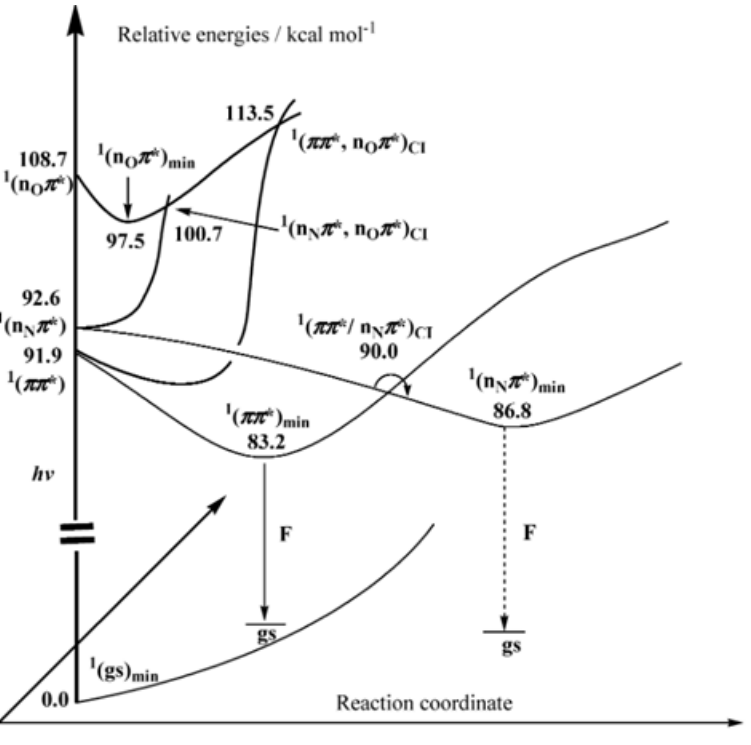
Figure 15. Relative energy profiles for the low-lying excited states (*) of acidic pterin [139]. © 2022 American Chemical Society.